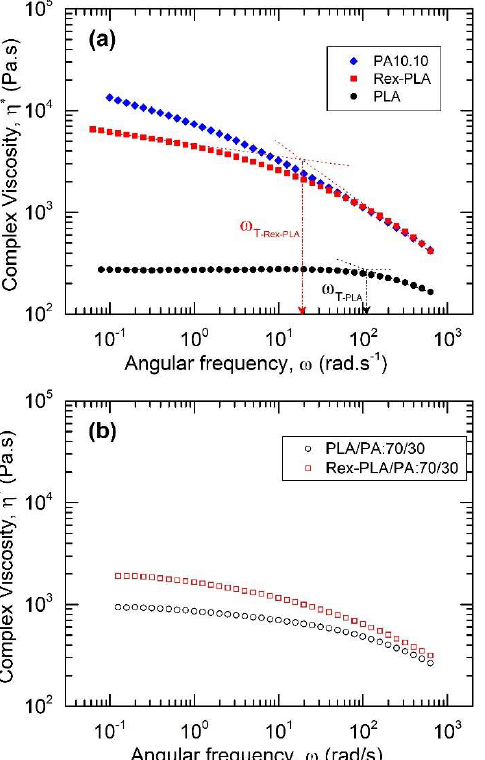
Figure 7. Flow curves ( η * vs. ω ) of neat polymers ( a ) and bioblend prepared with 70% of PLA ( b ). ω T : estimated angular frequency where Newtonian-shear thinning behavior is observed. T = 215 ° C.